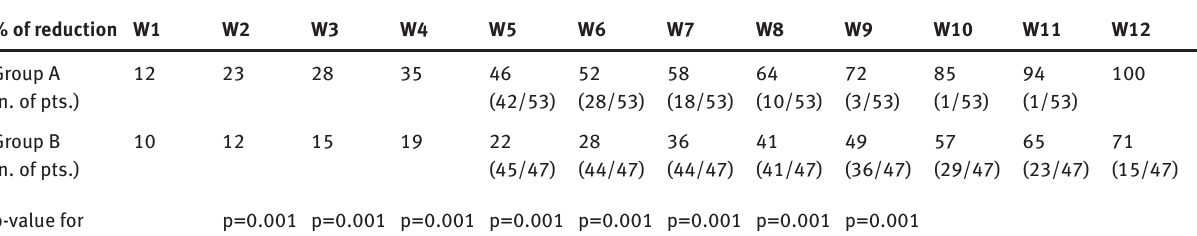
Table 2: Median percentage of reduction of wound area for repeated comparisions during the observational period (W1 à W2) in patients treated with CGF dressing + compression (Group A) and standard dressing + compression (Group B).